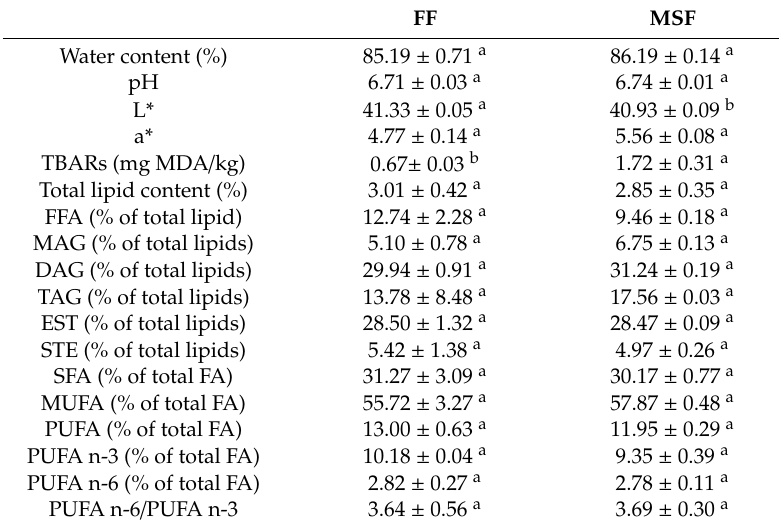
Table 1. Physico-chemical parameters, thiobarbituric acid reactive substances (TBARs), main lipid classes and fatty acid classes of fresh mantis flesh obtained by manual (FF) and mechanical separation